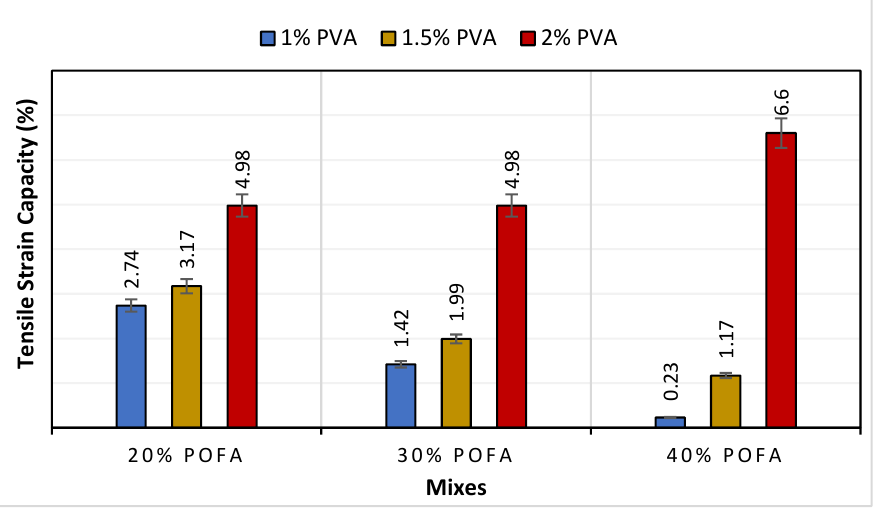
Figure 7. Tensile strain capacity of POFA-ECC mixes.